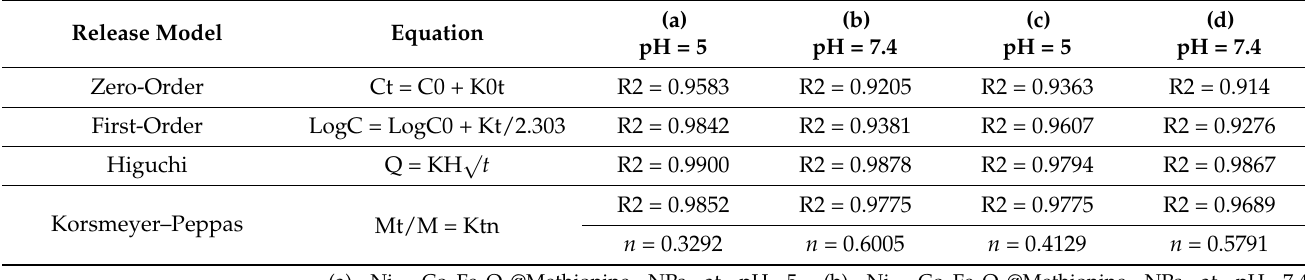
Table 1. The release kinetic models and the parameters obtained for the carriers.